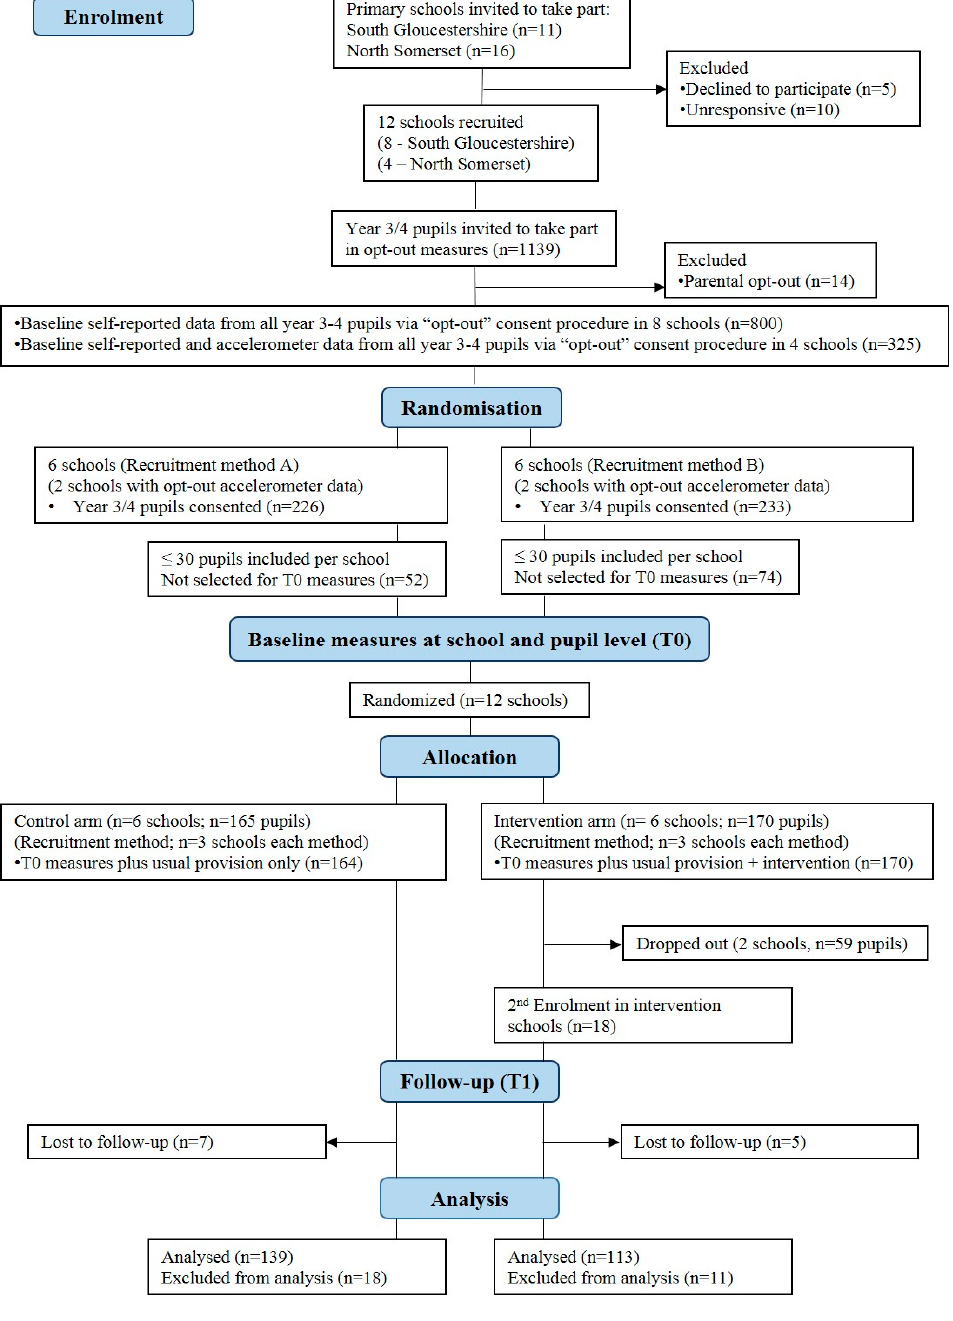
Figure 1. Flow diagram for Action 3:30R trial (based on CONSORT 2010 flow diagram).